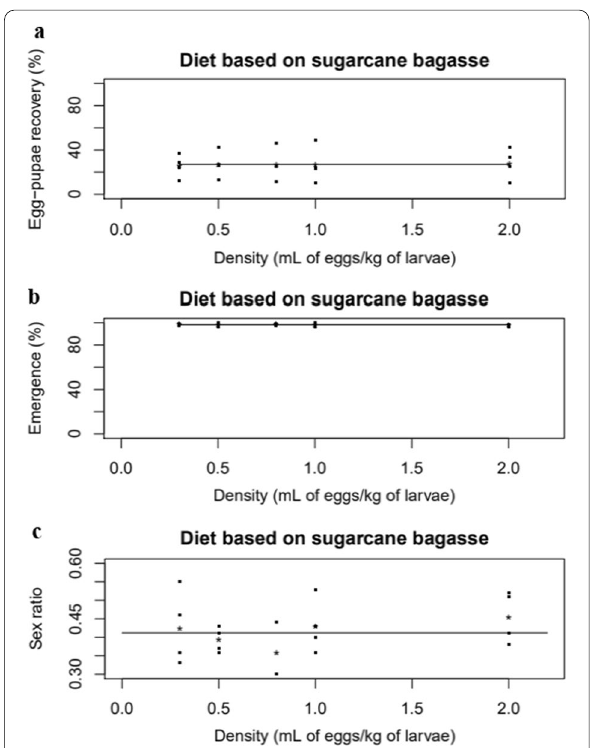
Fig. 2 Larval diet based on sugarcane bagasse. a Egg-pupae recovery: plot with the fitted curve and observed percentages versus density. b Emergence: plot with the fitted curve and observed percentages versus density. c Sex ratio: plot with the fitted curve and observed proportions versus